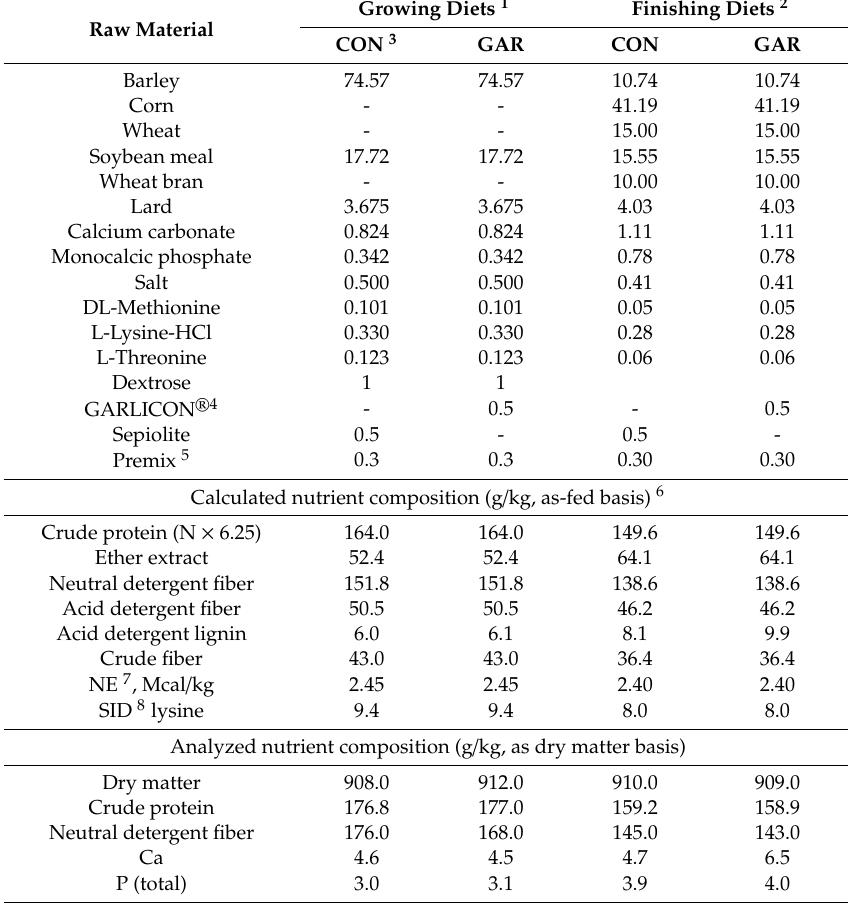
Table 1. Diet Composition (%) and nutrient levels of diets (g / kg, as-fed basis) for growing-finishing pigs. Raw